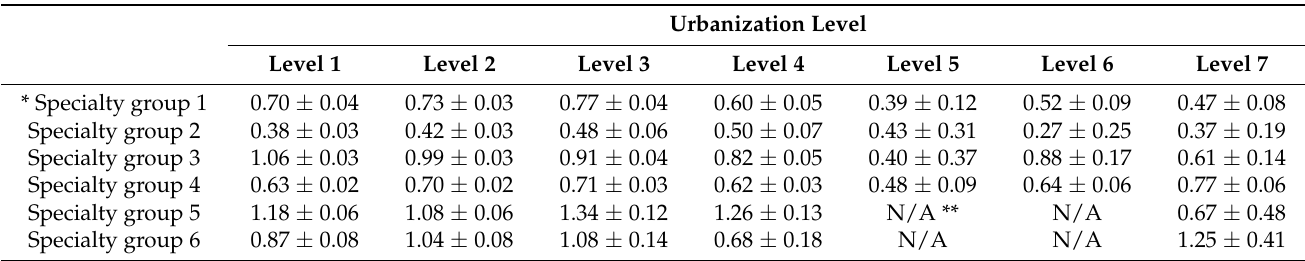
Table A1. The average number of pharmacists at clinics by urbanization level and specialty group, with their mean and standard